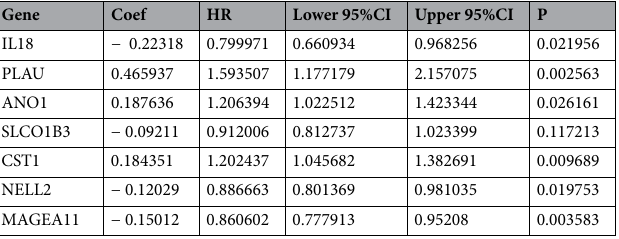
Table 3. Multivariate Cox regression analysis of the 7-gene signature. HR hazard ratio, CI confidence